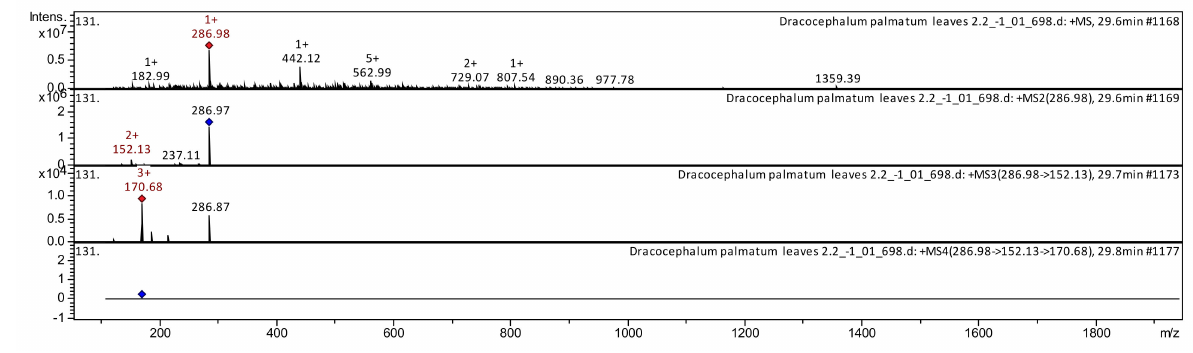
Figure 4. CID spectrum of luteolin from extracts of D. palmatum , m / z 286.98.